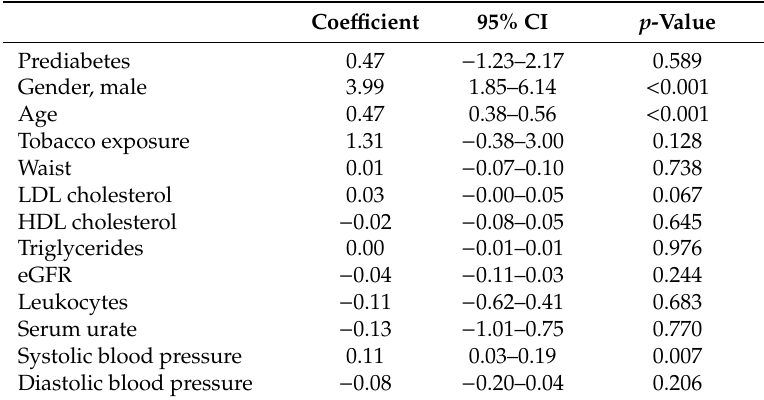
Table 3. Linear regression analysis for the predictors of